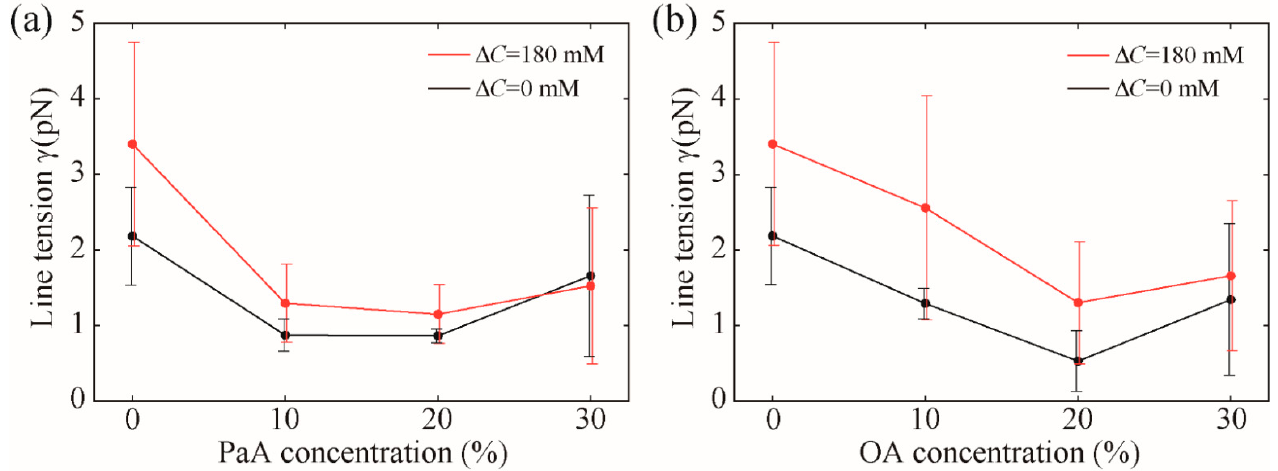
Figure 2. Line tension at the L o /L d phase boundary for ( a ) DOPC/DPPC/PaA/Chol and ( b ) DOPC/DPPC/OA/Chol. PaA (or OA) = 0%, 10%, 20%, and 30% correspond to DOPC/DPPC/PaA(OA)/Chol = 40/40/0/20, 30/40/10/20, 20/40/20/20, and 10/40/30/20, respectively. The black and red lines represent the results for Δ C = 0 mM (without osmotic stress) and 180 mM (with osmotic stress), respectively.